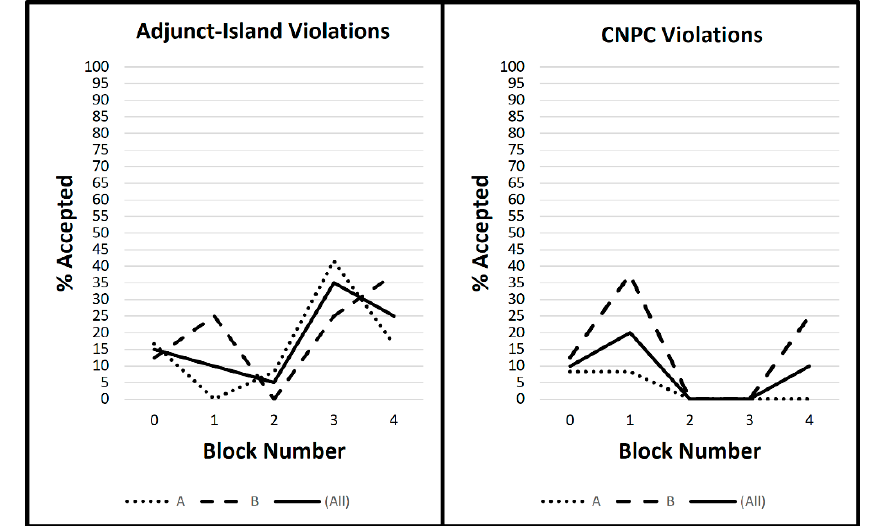
Figure 2. Experiment I, Adjunct-Island and CNPC violations.